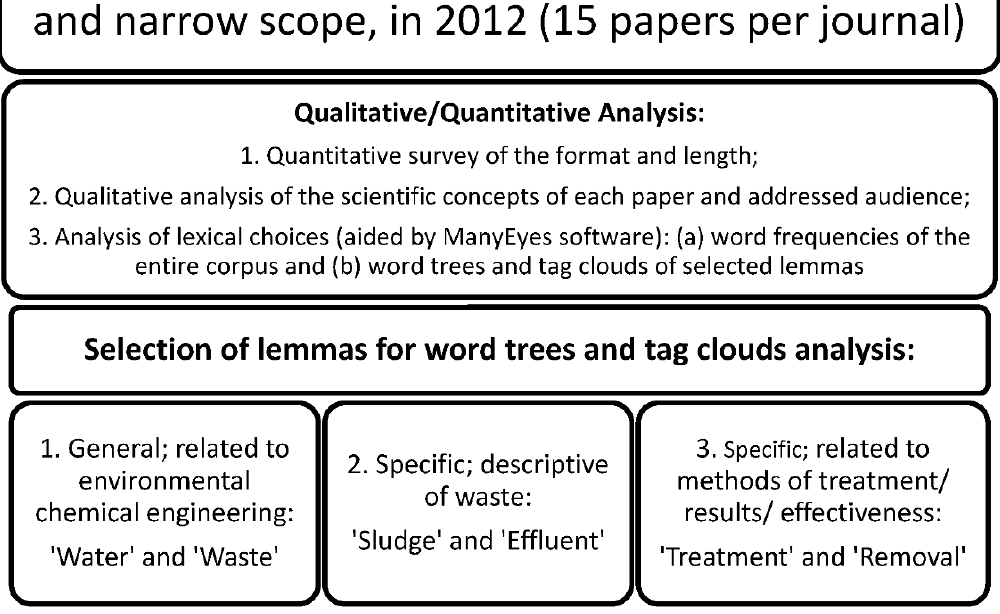
Figure 1. Schematic representation of the methodology developed and followed in this case study.